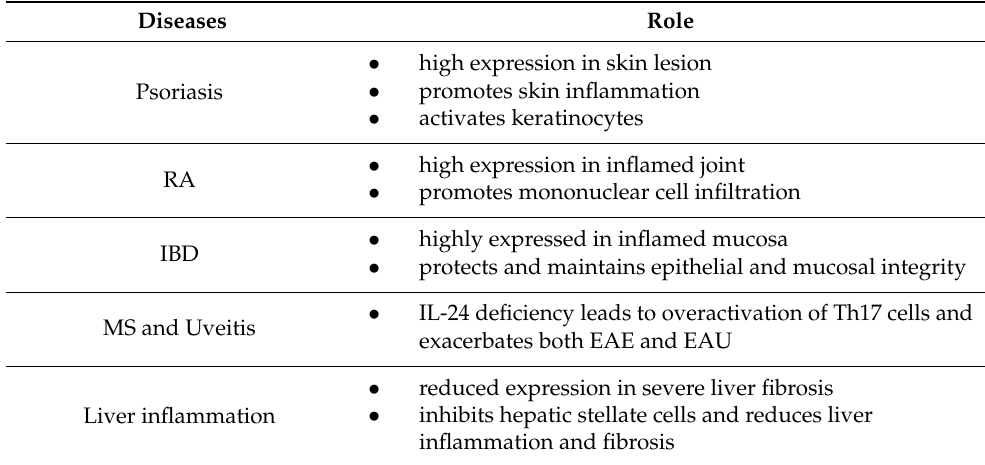
Table 2. IL-24 in inflammatory and autoimmune